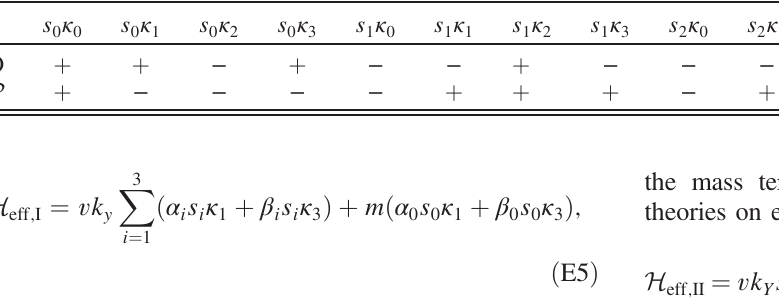
κ matrices. In the table, we use i j